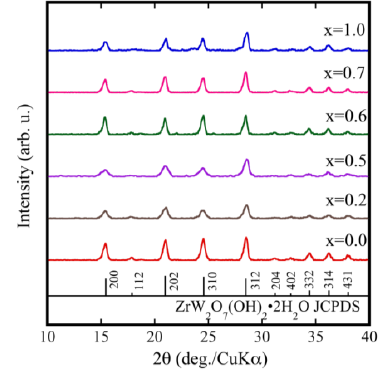
Figure 1. X-ray powder diffraction (XRD) patterns of ZrW 2 − x Mo x O 7 (OH) 2 ·2H 2 O precursor powders in a sol-gel method ( a ); and a sol-gel method combines with hydrothermal method ( b , c ).